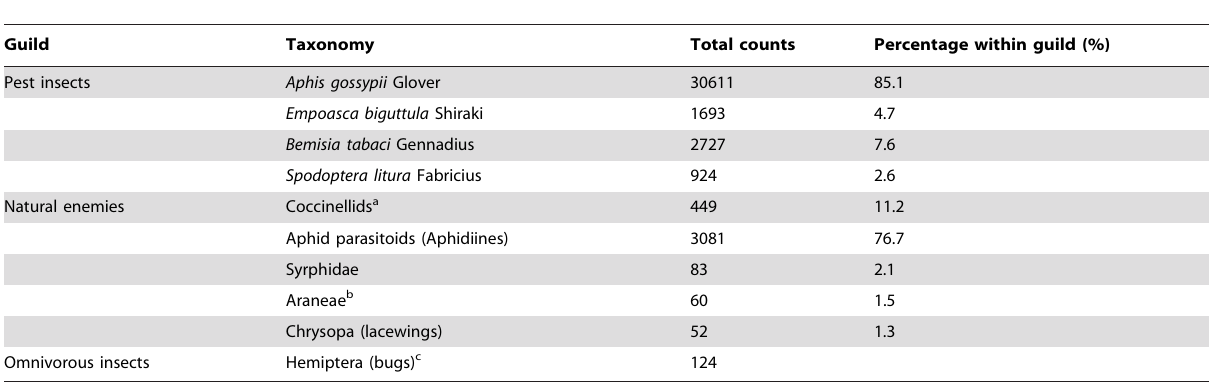
Table 1. Dominant arthropods, per guild, found during the surveys.